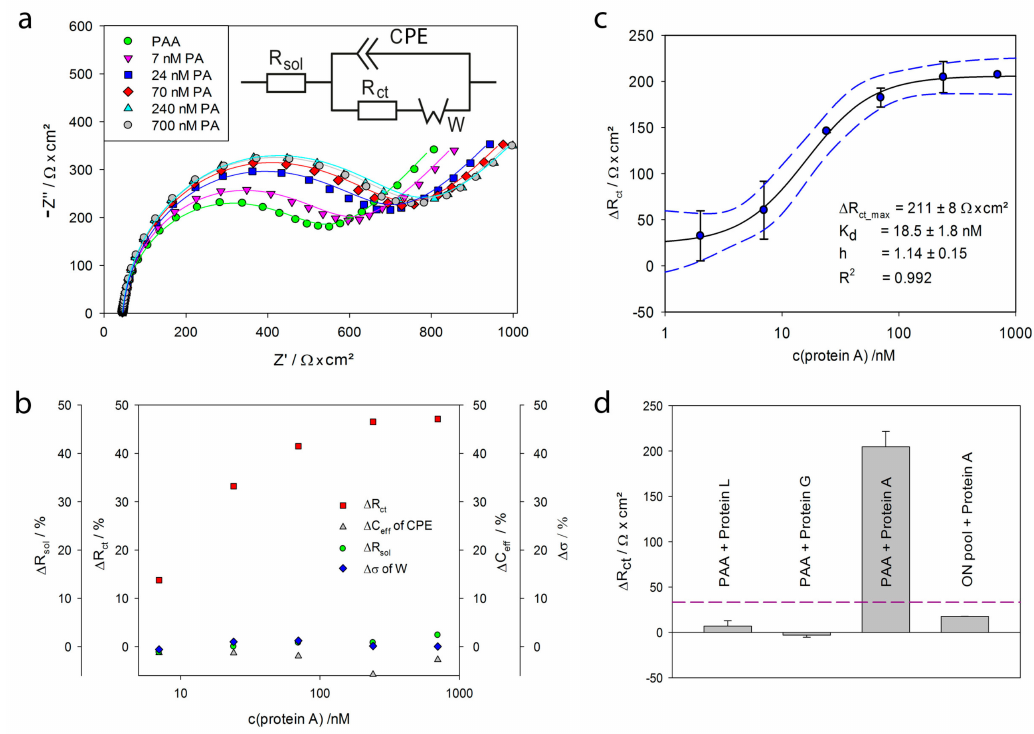
Figure 6. Electrochemical impedance spectroscopy measurements with protein A: ( a ) Nyquist plot of a PAA-modified electrode before (green circles) and after incubation with 7–700 nM protein A measured in FeBB—the fits to the equivalent circuit are shown as lines—modified Randles circuit with R sol : solution resistance, CPE : constant phase element, R ct : charge-transfer resistance and W : Warburg impedance; ( b ) the percentage change of the different fit parameters for all protein A concentrations, C eff : the effective capacitance was calculated from the CPE under the assumption of a parallel distribution of time constants on the electrode surface as described in [44], σ is the parameter for the Warburg element; ( c ) binding curve: Change of the extracted charge transfer resistance ∆ R ct of aptamer-modified electrodes upon incubation of protein A measured in triplicate—dashed blue lines mark the 95% confidence interval; ( d ) unspecific signals: Extracted ∆ R ct of 1 µ M protein G, protein L and protein A on PAA-modified electrodes as well as 1 µ M protein A on electrodes modified with random oligonucleotides measured in triplicate—the dashed line represents the LoD.